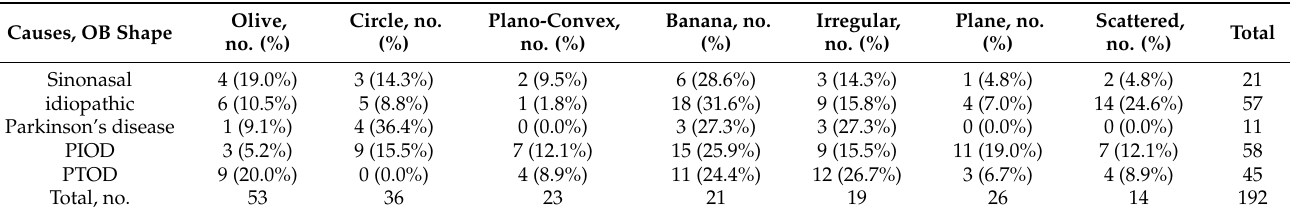
Table 3. Prevalence of OB shapes in patients with different